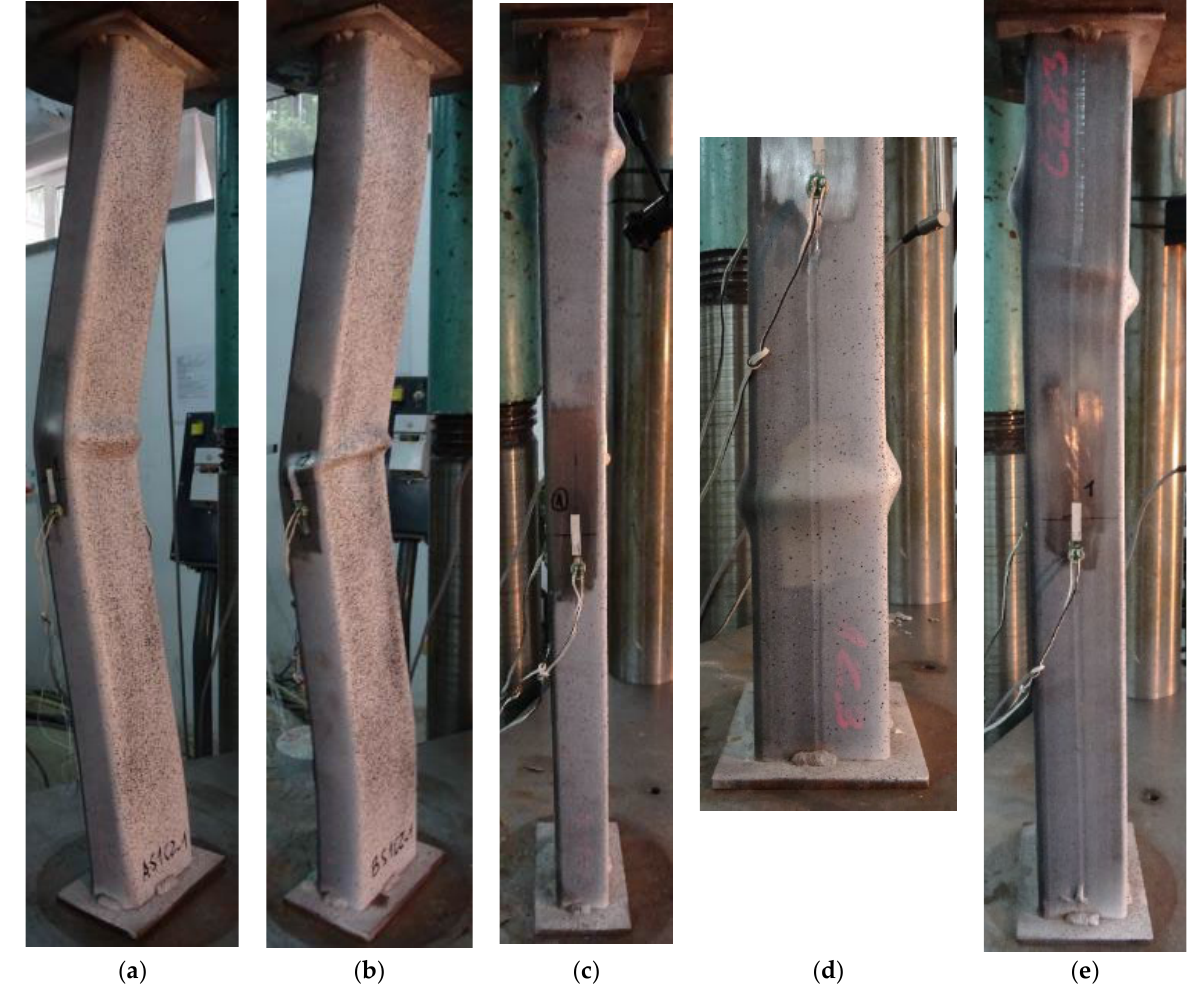
Figure 11. Typical failure modes of composite columns observed during the experiment: ( a ) global buckling of slender columns from series A; ( b ) global buckling of single specimen BS1C2_1; ( c ) local shear and sliding failure of slender columns from series B (except BS1C2_1); ( d ) elephant foot (splitting) failure of single specimen DS2C1_1; ( e ) local shear and sliding failure of moderate slender columns from series D (except DS2C1_1).